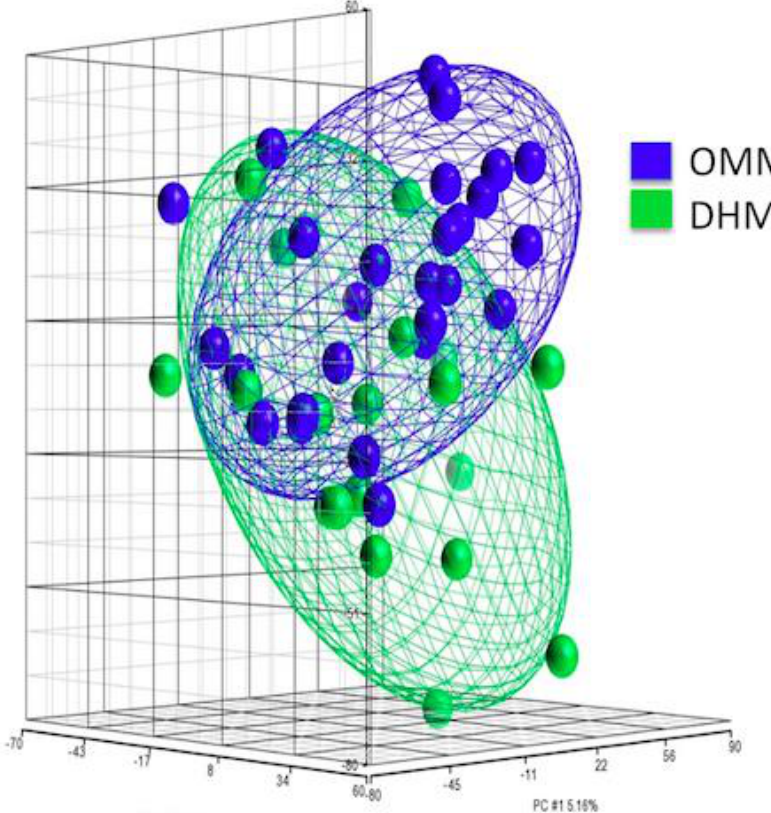
In the 3-dimensional plot, the three principal components PC#1, #2 and #3 of all samples with over 20,000 well-annotated genes and their respective variations are expressed on the x-, y- and z-axis. The total percentage of PCA mapping variability is 12.1%. Each data point represents one sample. (blue) and DHM